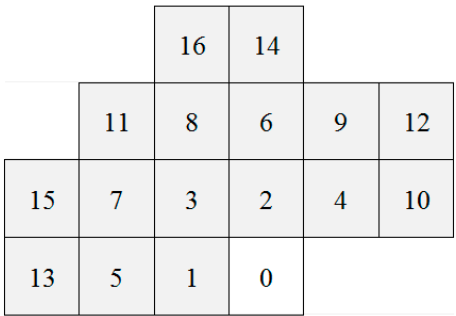
Figure 2. The enumeration E we used for the relative indexing with respect to the current pixel, identified with 0 as index.